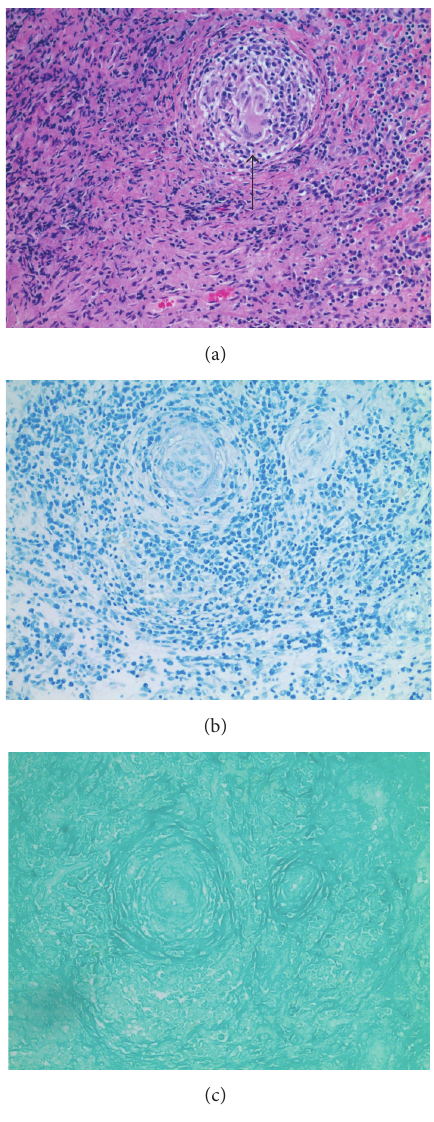
Figure 5: Histopathology of the resected small-bowel lesion. (a) H&E stain revealed lymphohistiocytic noncaseating granuloma with multinucleated giant cells (black arrow). (b) Negative for acid- fast bacilli (AFB) stain. (c) GMS stain negative for fungal